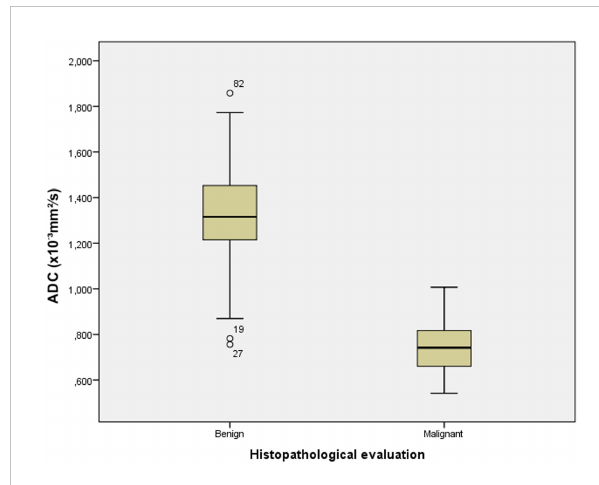
FIGURE 4 The box-and-whisker plots show the ADC values of benign and malignant endometrial lesions according to histopathological analysis.